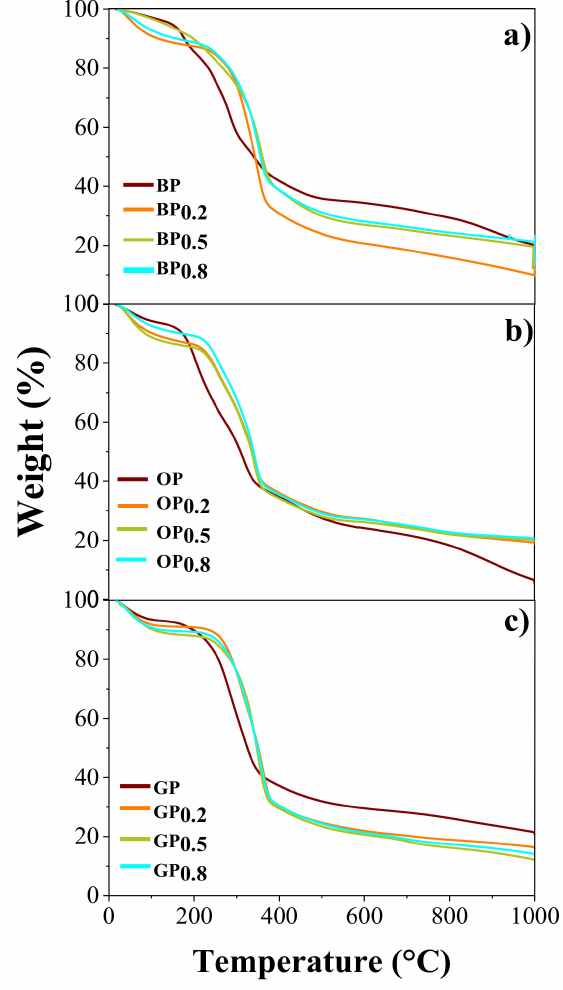
Figure 1. Thermogravimetric analysis profiles of ( a ) Banana (BP), ( b ) Orange (OP), and ( c ) Granadilla (GP) unmodified and chemically modified